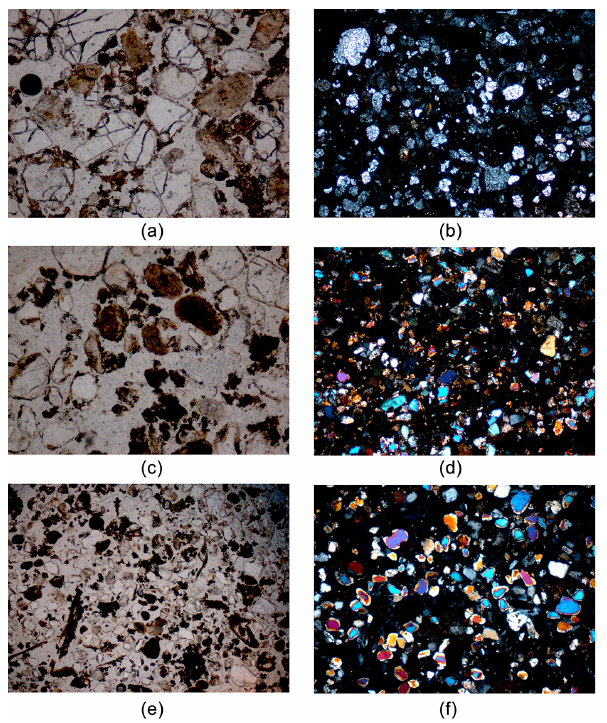
Figure 4. Thin sections. (a, b) Crown fire; (c, d) surface fire; (e, f) nature plot. Left column – transmitted light; right column – crossed nicols.